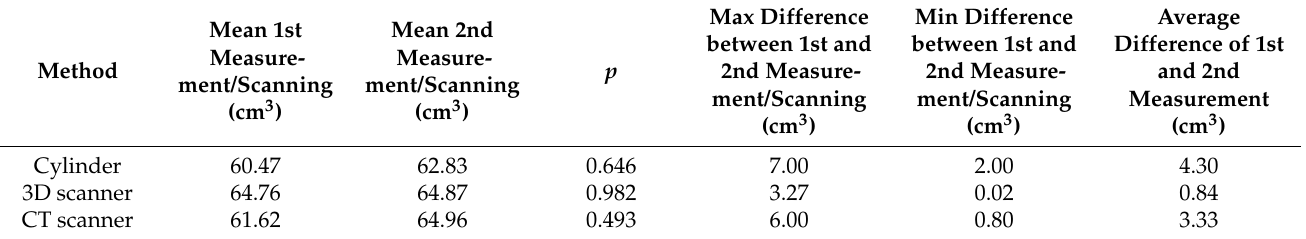
Table 6. Difference in the accuracy of the methods used for volume measuring of all (30 samples) roe deer antlers.